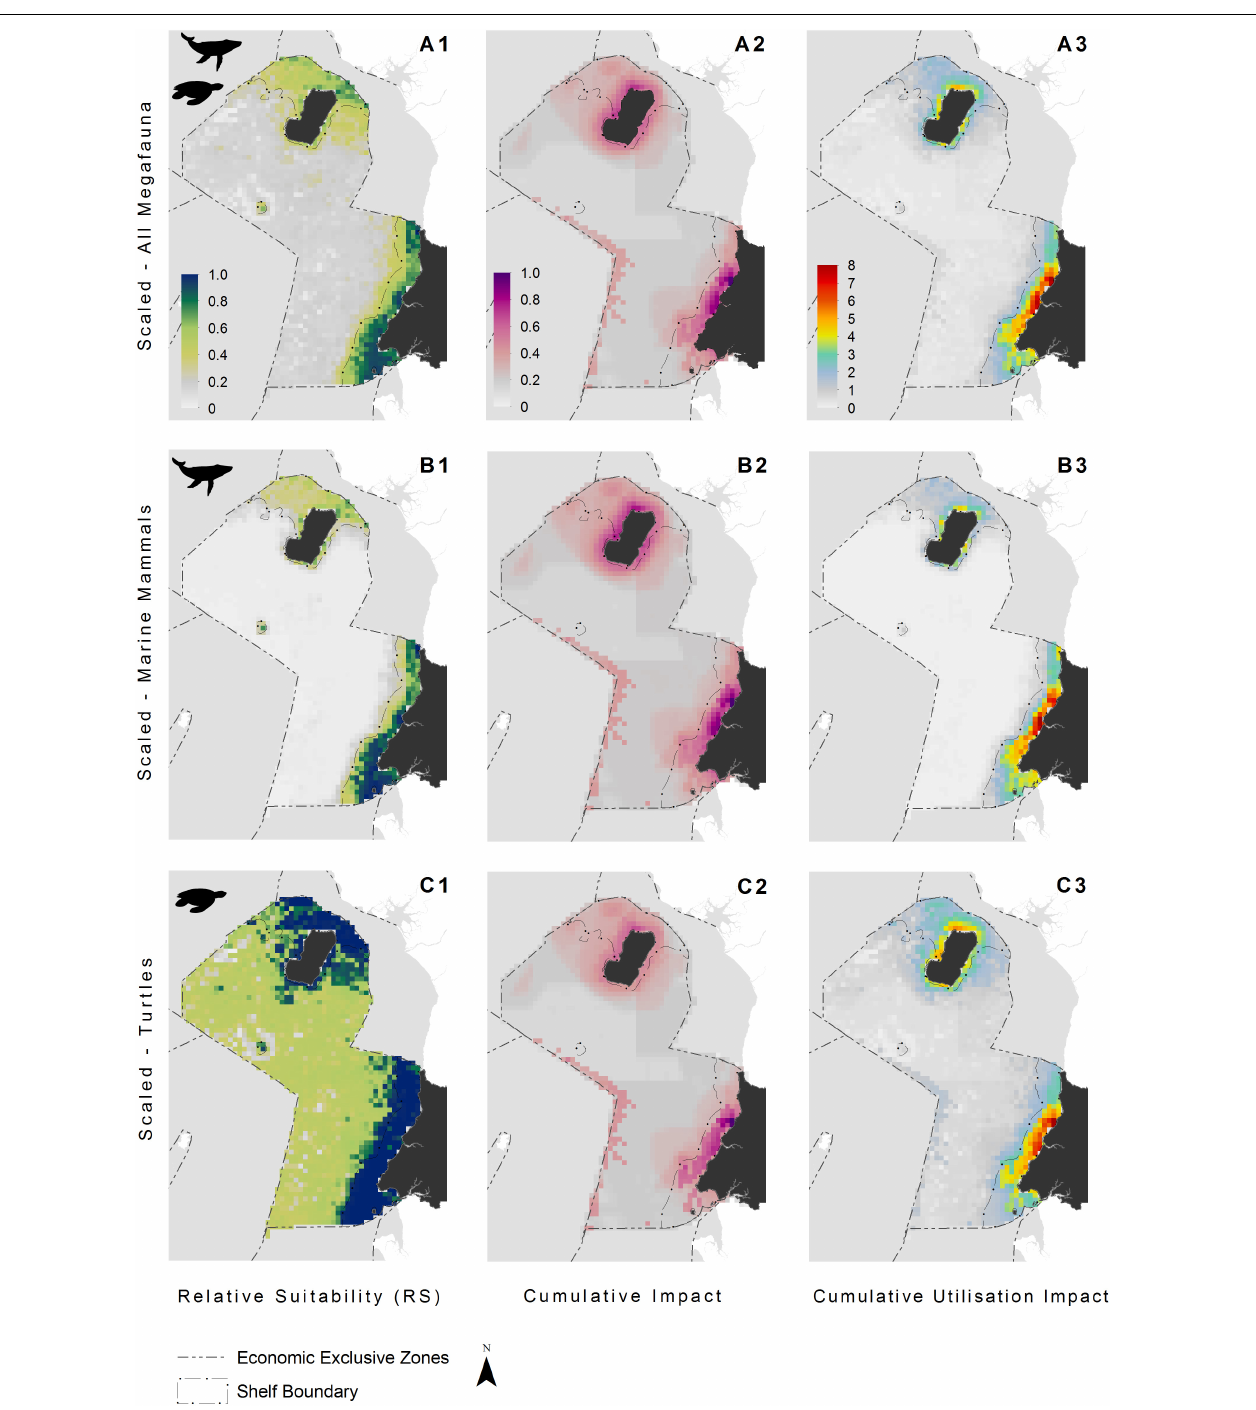
FIGURE 3 | Species distribution models indicating the relative suitability of habitats for: (A1) all megafauna species ( n = 5: humpback whale, bottlenose and Atlantic humpback dolphin, leatherback and olive ridley sea turtles); (B1) marine mammals ( n = 3: humpback whale, bottlenose and Atlantic humpback dolphin); and (C1) sea turtles ( n = 2: leatherback and olive ridley sea turtles). Cumulative impact distributions (activity intensity weighted by the vulnerability of a species to said activity) showing pressure hotspots for: (A2) all megafauna species ( n = 5: humpback whale, bottlenose and Atlantic humpback dolphin, leatherback and olive ridley sea turtles); (B2) marine mammals ( n = 3: humpback whale, bottlenose and Atlantic humpback dolphin); and (C2) sea turtles ( n = 2: leatherback and olive ridley sea turtles). Cumulative utilization impact distributions for: (A3) all megafauna species ( n = 5: humpback whale, bottlenose and Atlantic humpback dolphin, leatherback and olive ridley sea turtles); (B3) marine mammals ( n = 3: humpback whale, bottlenose and Atlantic humpback dolphin); and (C3) sea turtles ( n = 2: leatherback and olive ridley sea turtles). See Figure 1 for additional geographical information for the Bioko-Corisco-Continental area of Equatorial Guinea’s exclusive economic zone.